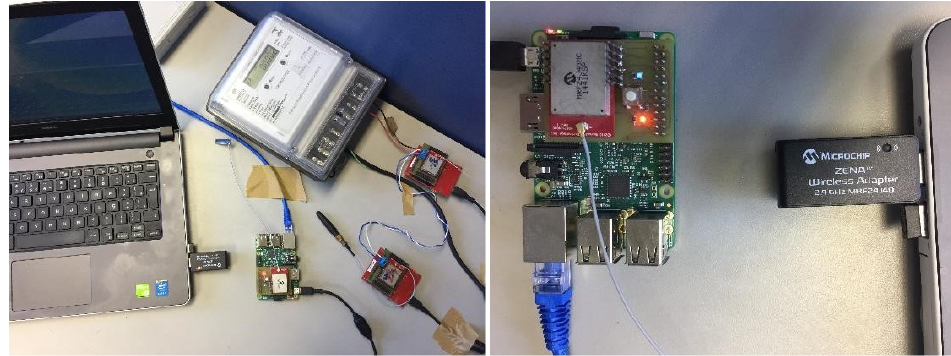
Figure 14. ( left) WSN with a sniffer adapter to capture the packets, and ( right) the sink node and the sniffer adapter.